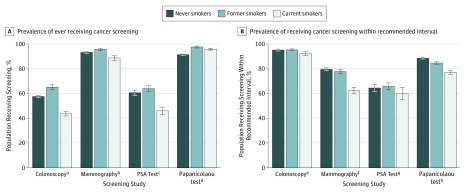
Weighted Prevalence of Receiving Cancer ScreeningError bars indicate 95% CIs; PSA, prostate-specific antigen.aIncludes adults aged 50 to 75 years.bIncludes women aged 50 to 74 years.cIncludes men aged 55 to 69 years.dIncludes women aged 21 to 65 years without prior hysterectomy.eIndicates within 10 years.fIndicates within 2 years.gIndicates within 1 year.hIndicates within 3 years.